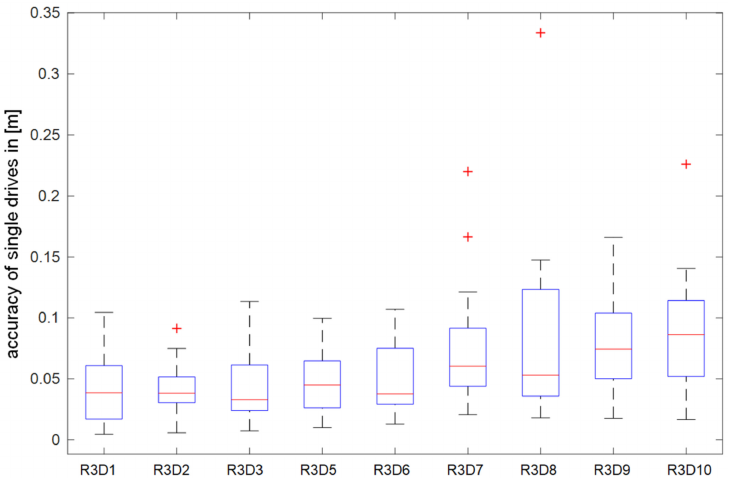
Figure 9. The box plots show the deviations of the closest neighbors (accuracy) for each single drive from run 3 in the route section. (+—maximum